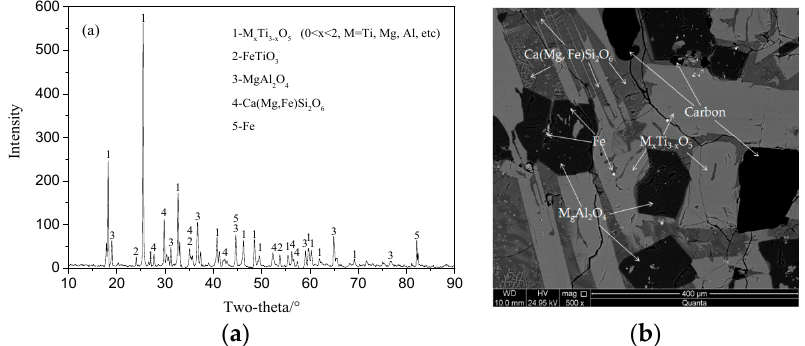
Figure 1. XRD pattern ( a ) and scanning electron micrograph ( b ) of the original titanium-bearing electric furnace slag (TEFS).